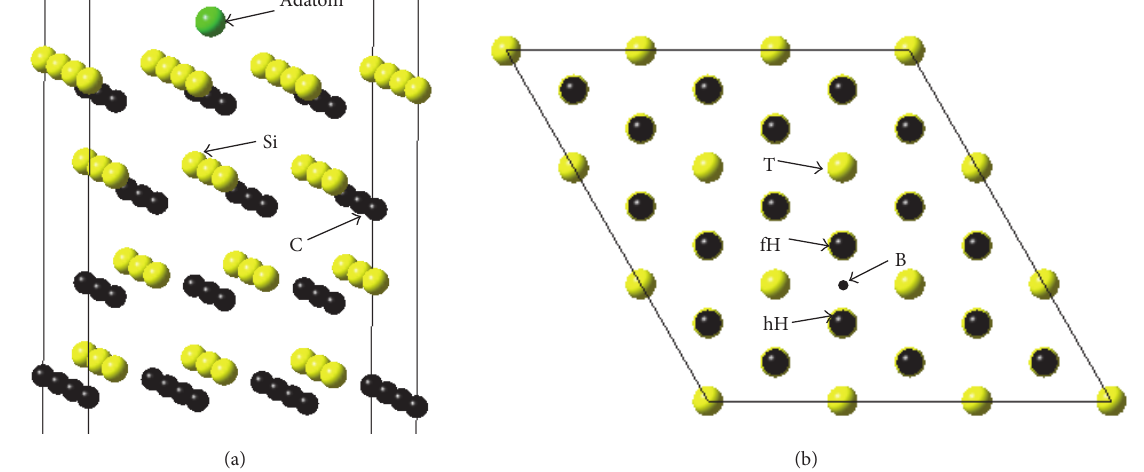
Figure 2: (a) The supersurface of Co on SiC. (b) The adsorption sites on the SiC surface, where T, B, and H represent the Top, Bridge, and Hollow